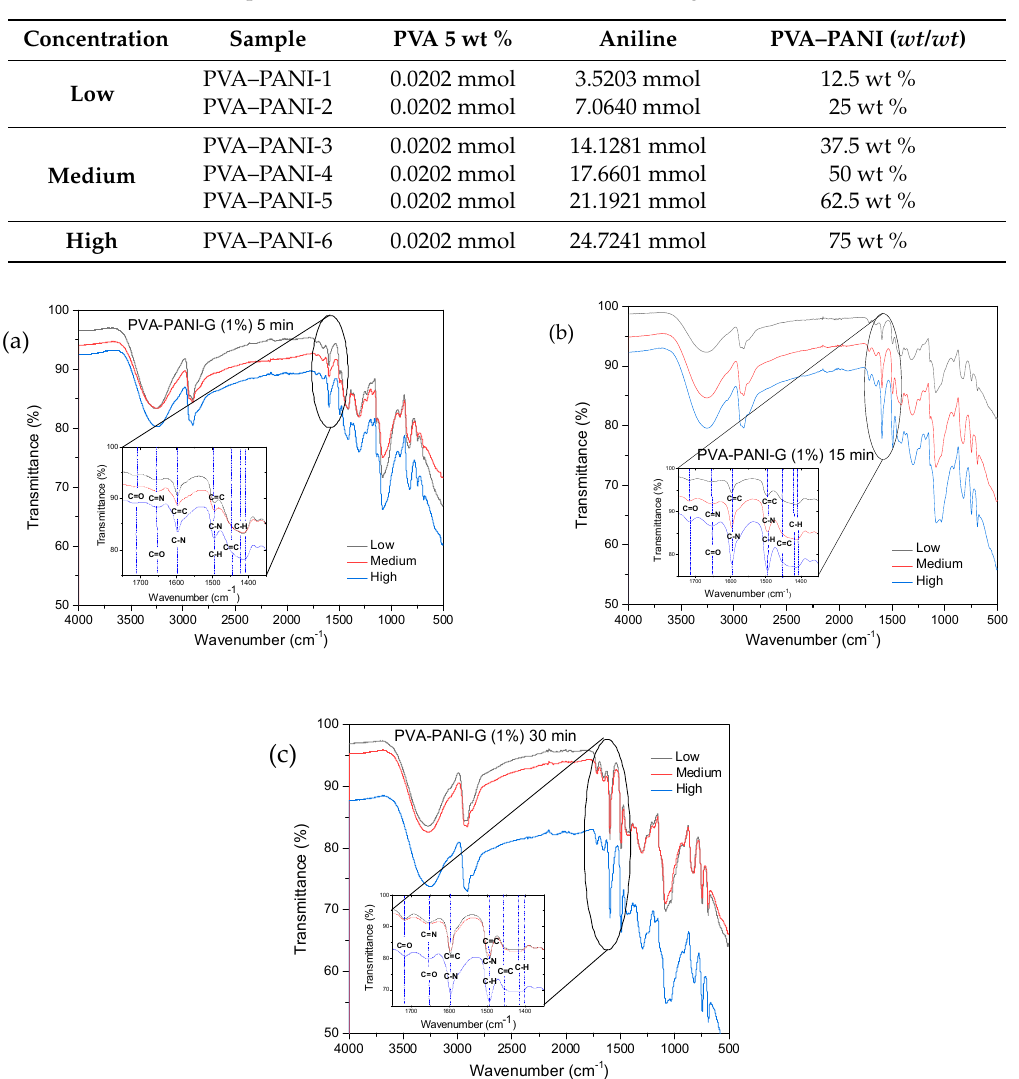
Table 1. Experiment of aniline concentration variation against PVA 5 wt %.